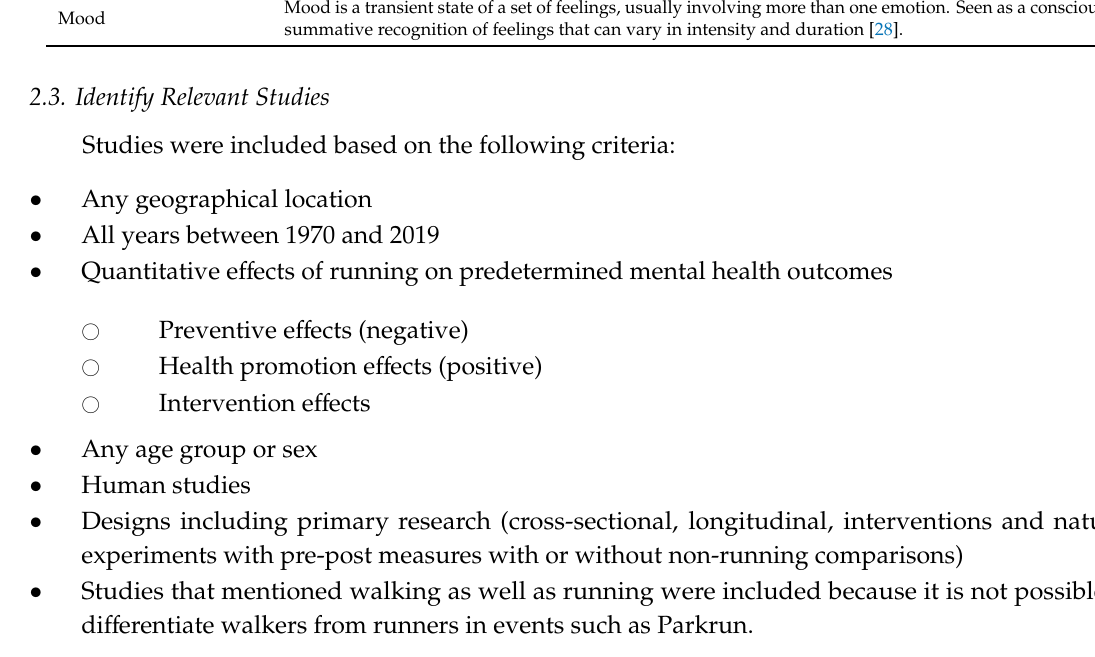
Self-e ffi cacy Psychological stress or distress can be defined as the unique discomforting, emotional state experienced Psychological stress by an individual in response to a specific stressor or demand that results in harm, either temporary or permanent, to that person